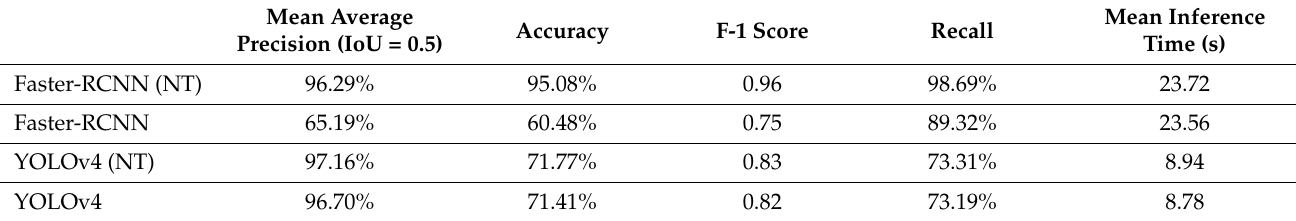
Figure 11. ( a ) Results of Faster RCNN before negative training and ( b ) Results of Faster RCNN after negative training. Table 1. Performance